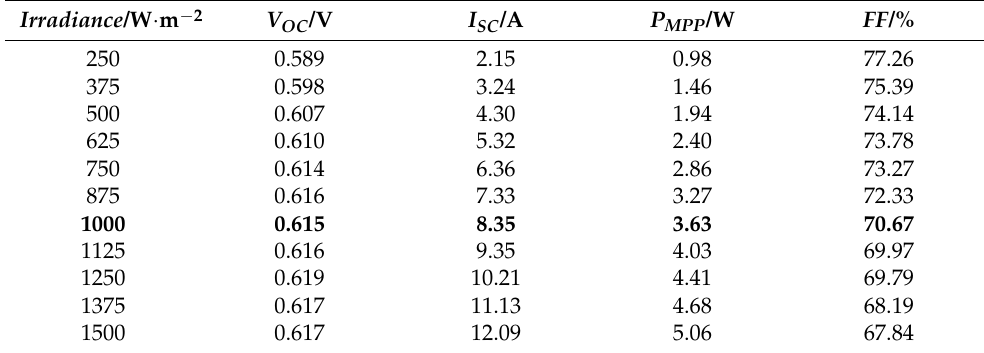
Figure 22. Details of the same I-V curve (Figure 20) near the abscise axis intersection with the second-degree polynomial fit of the points of each curve for the calculus of V OC . All relevant parameters obtained from the experimental curves shown in Figures 20–22 are shown in Table 3. Table 3. Technical characteristics of the PV cells used at nominal conditions (1000 W/m 2 of solar spectrum and 25 ◦